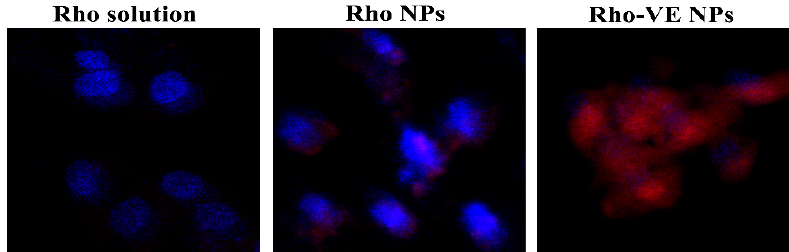
Figure 5. Confocal laser scanning microscope images of various Rhodamine 6G (Rho) labeled formulations in the MCF-7/ADR cells. Original magnification: 10 × 20.